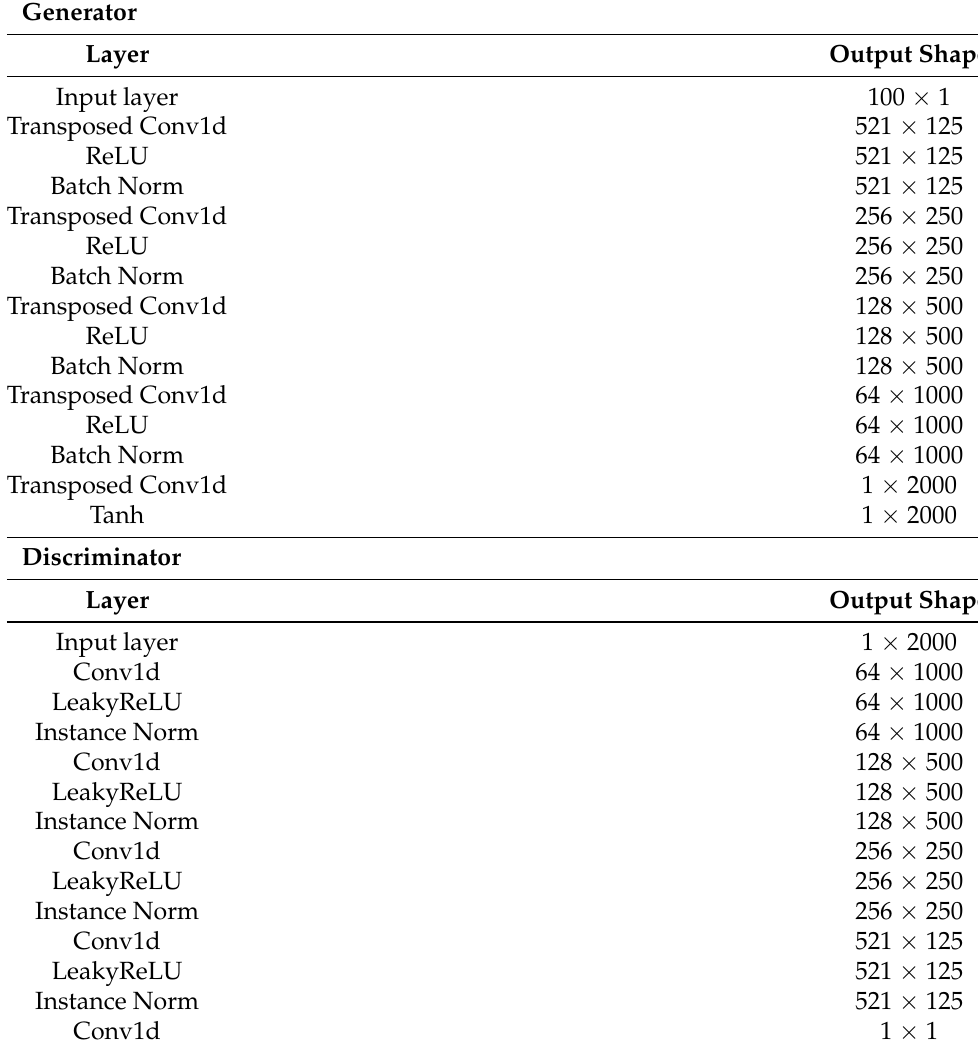
Table 1. The adopted architecture of the proposed generator and discriminator in our GAN-based data augmentation for wrist pulse